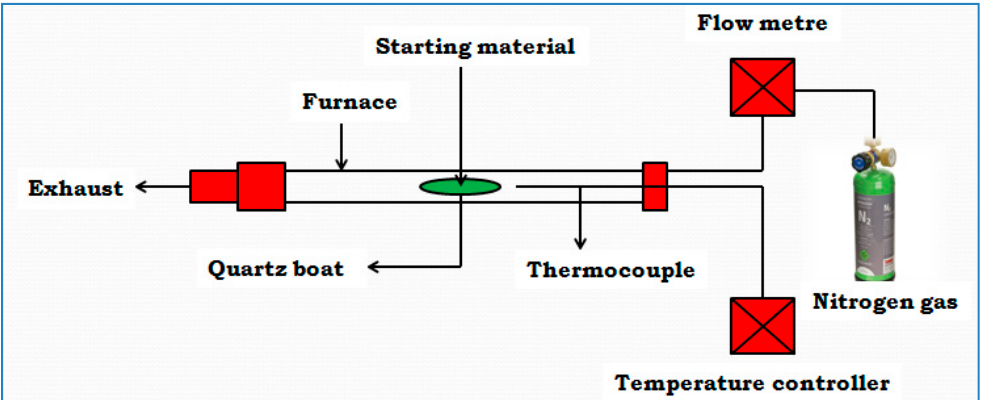
Figure 1. A simple diagram describing how the impregnated precursors were carbonized and activated in the furnace.